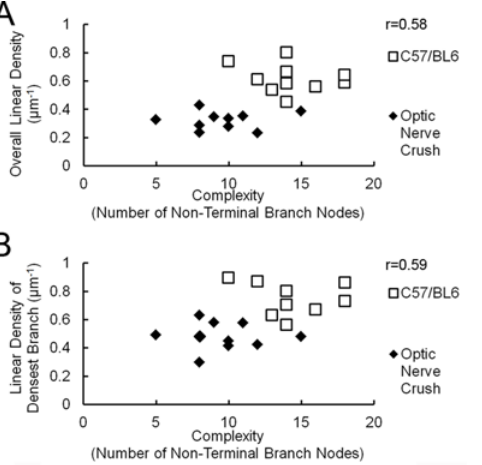
Fig 7. Correlation of synaptic density with complexity of the dendritic arbor in control C57bl/6 mice and in C57bl/6 mice after optic nerve crush. A, Scatterplot of synaptic density with complexity of the dendritic arbor in control retinas, and retinas after optic nerve crush. B, correlation of the synaptic density with complexity of the dendritic arbor for the densest branch.